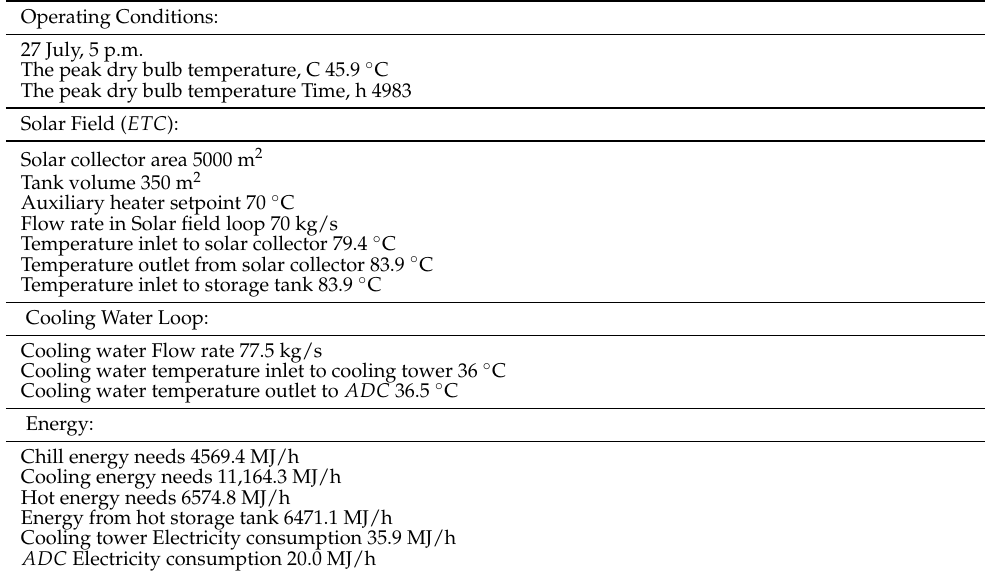
Table 7. The results of the ADC on a typical day/hour in summertime.